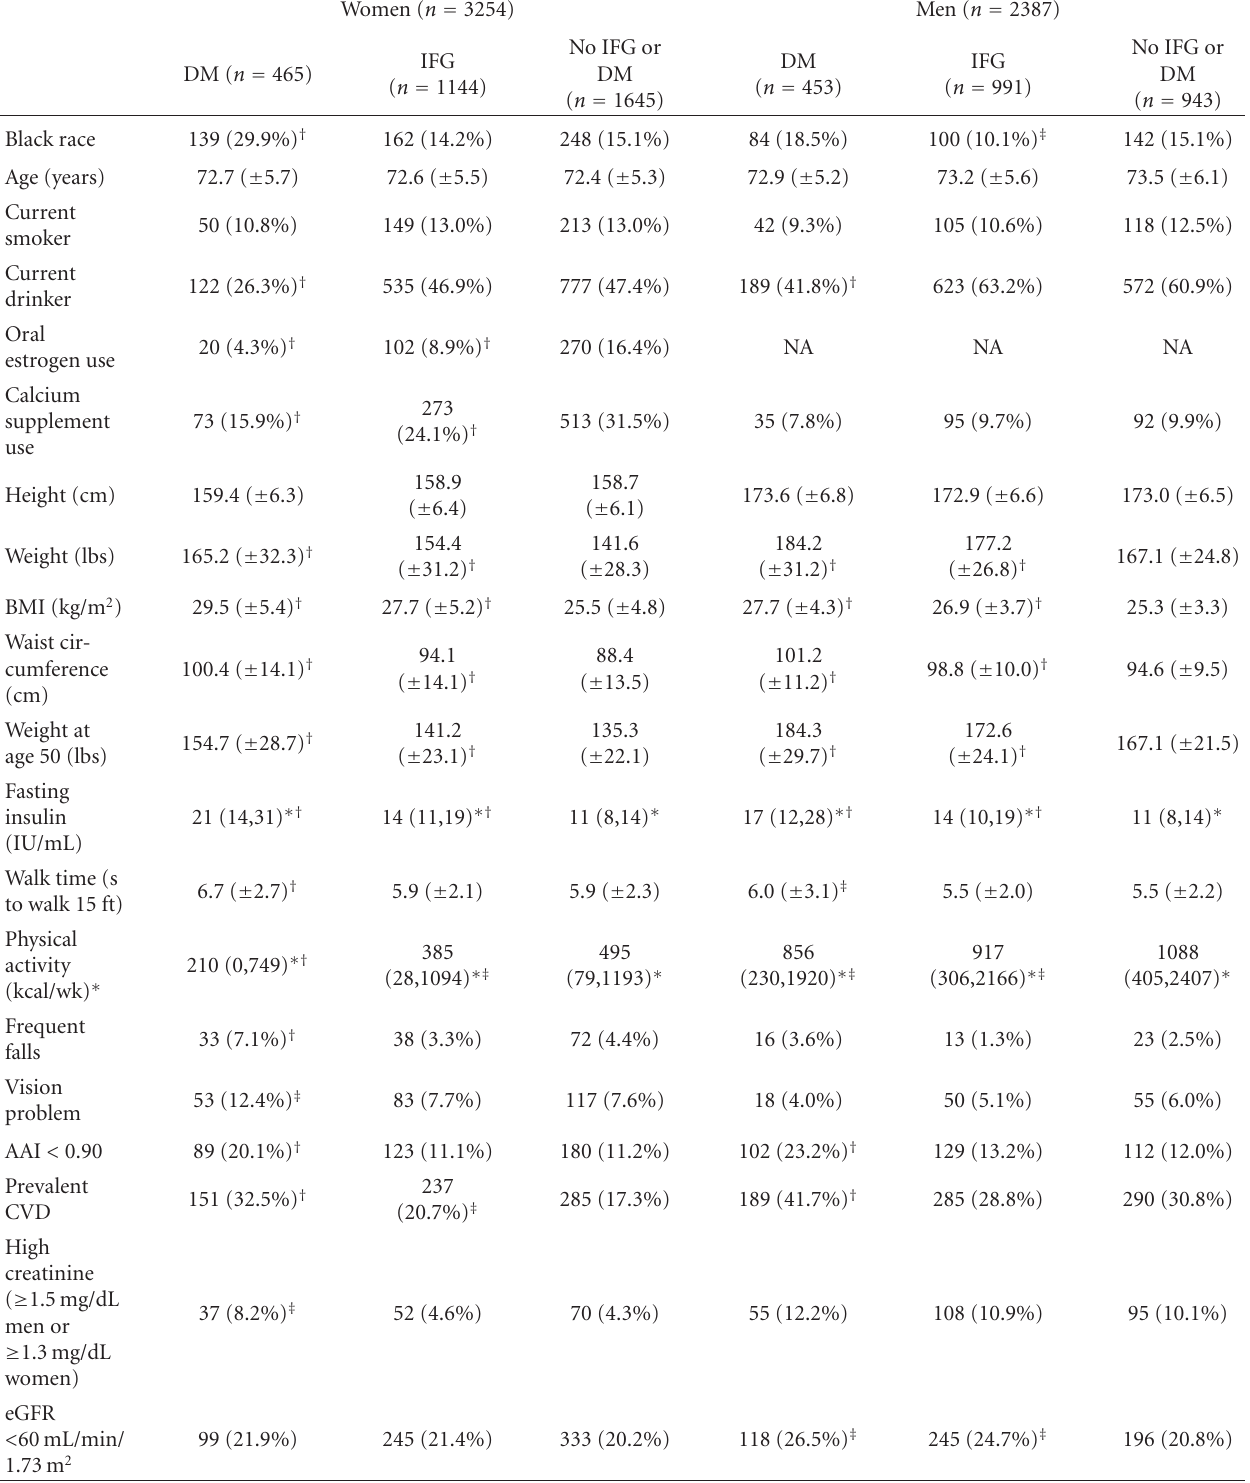
Table 1: Baseline descriptive characteristics by glycemic status for 5,641 women and men in the